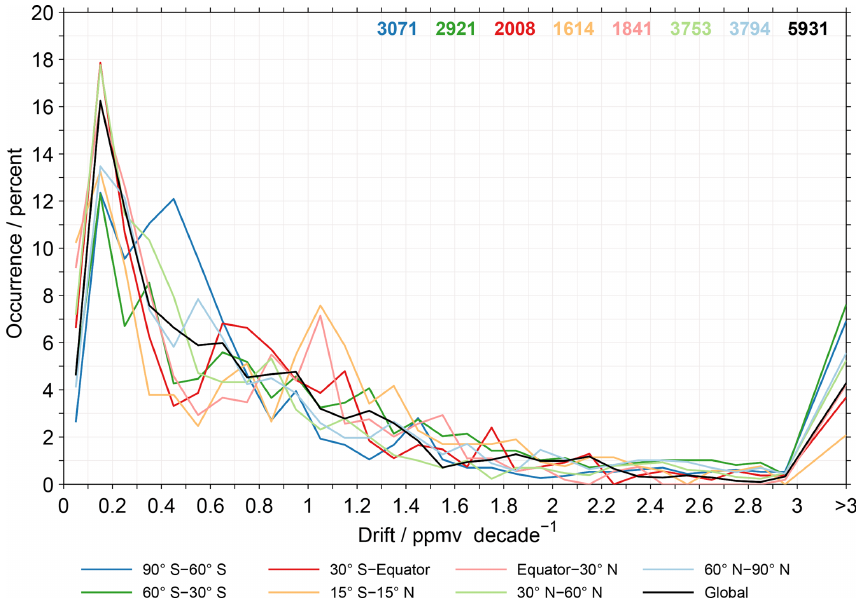
Figure 12. Drift histograms using estimates from all altitudes and taking into account the aggregation of the MIPAS results. Only positive drifts and those that are statistically significant at the 2 σ uncertainty level are considered in the calculation. The results for the different lati- tude bands are given by the different colours. In the upper-right corner the number of available data points is indicated, counting comparisons to different MIPAS data sets